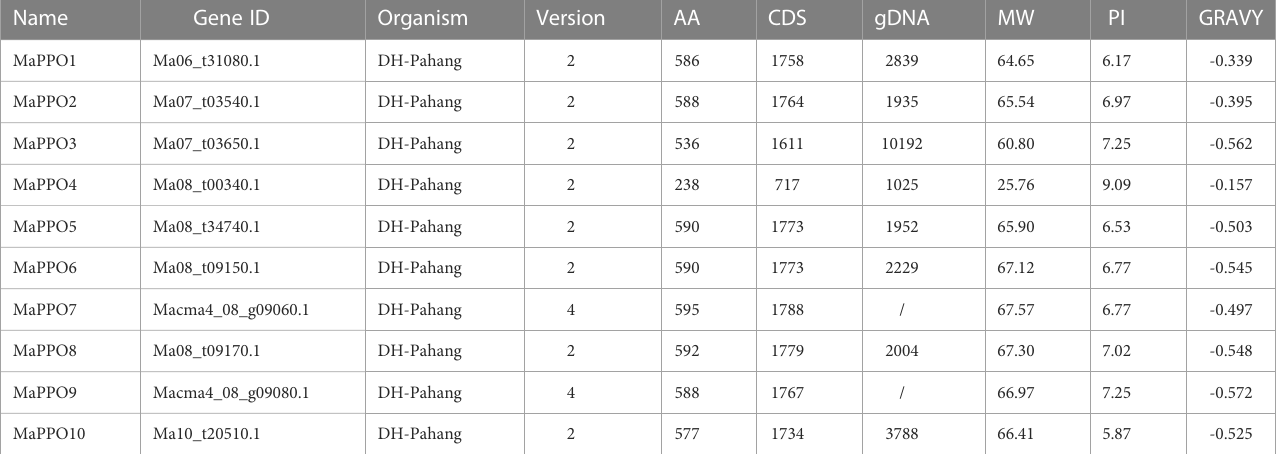
TABLE 1 Charcterization of MaPPOs